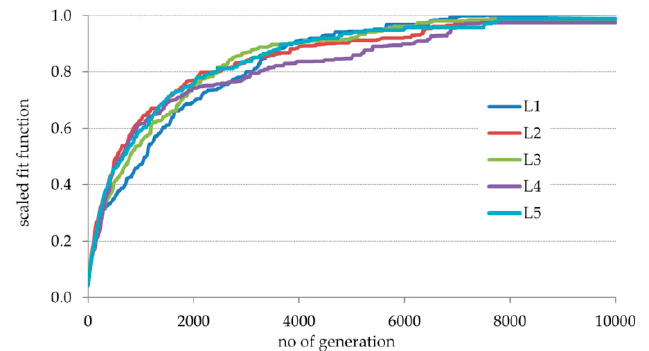
Figure 10. Progress of the process of the optimization of lines topology.